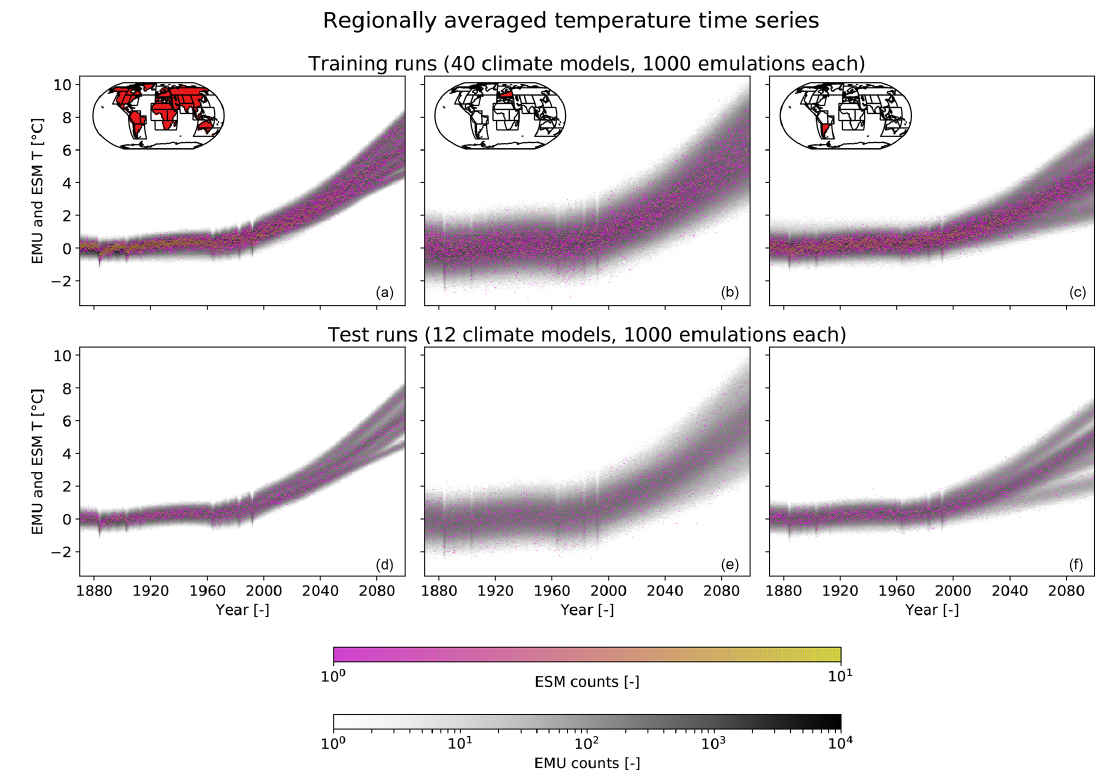
Figure 8. Regionally averaged time series as 2-D histograms for 40 CMIP5 model training runs and 1000 emulations per model (a–c) as well as for 12 CMIP5 models with one test run and 1000 emulations per model (d–f) . For the CMIP5 model runs a color map from pink to yellow is employed, and for the emulations a grayscale is used. The regions are global land (a, d) , CEU (b, e) , and SSA (c, f) .